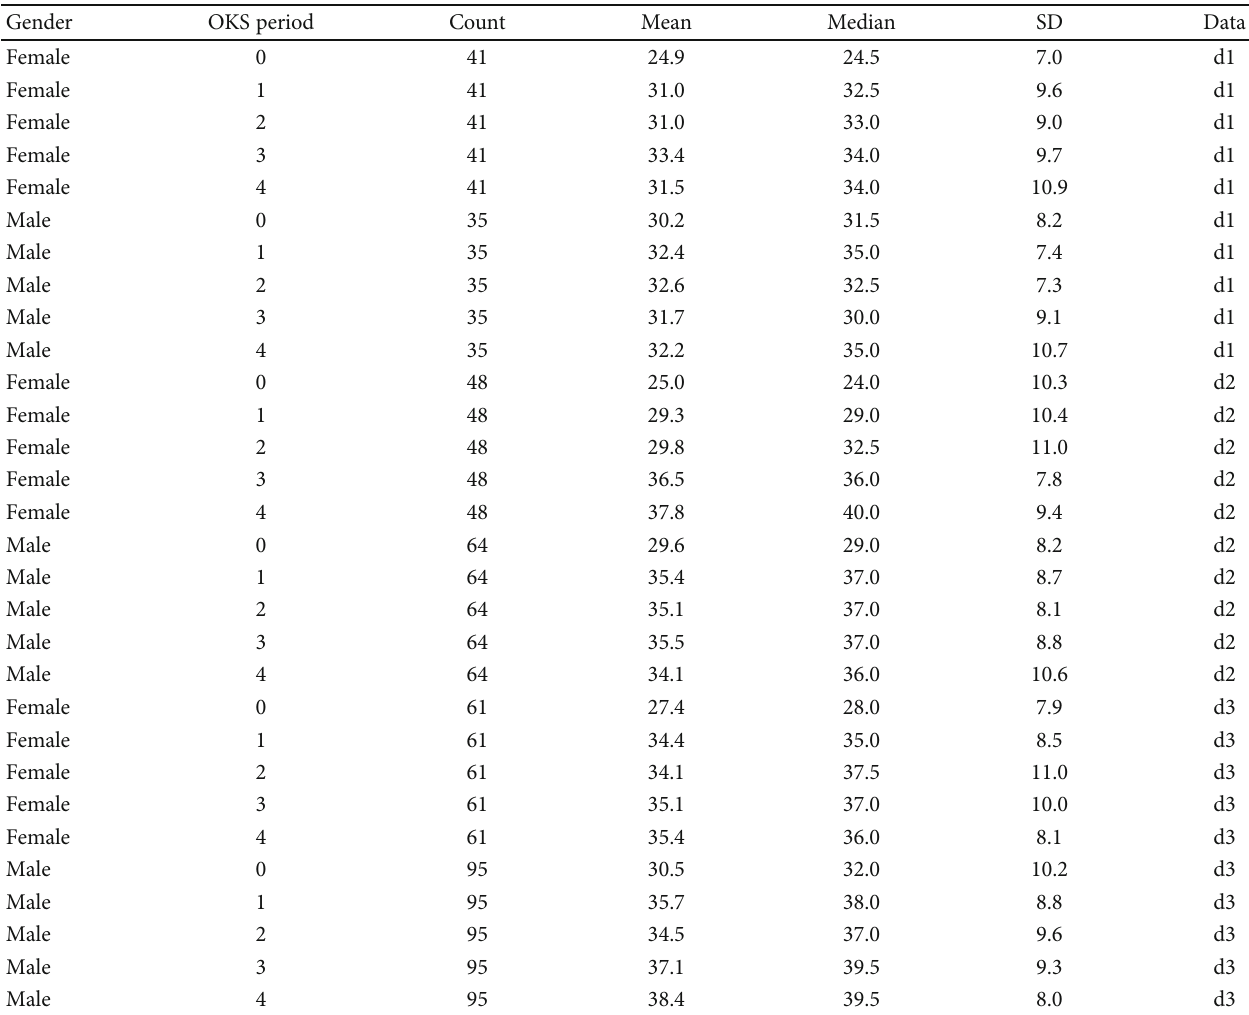
Table 6: Patients grouped by age at time of treatment (baseline) with follow-up OKS at 3, 6, 12, and 24 months.